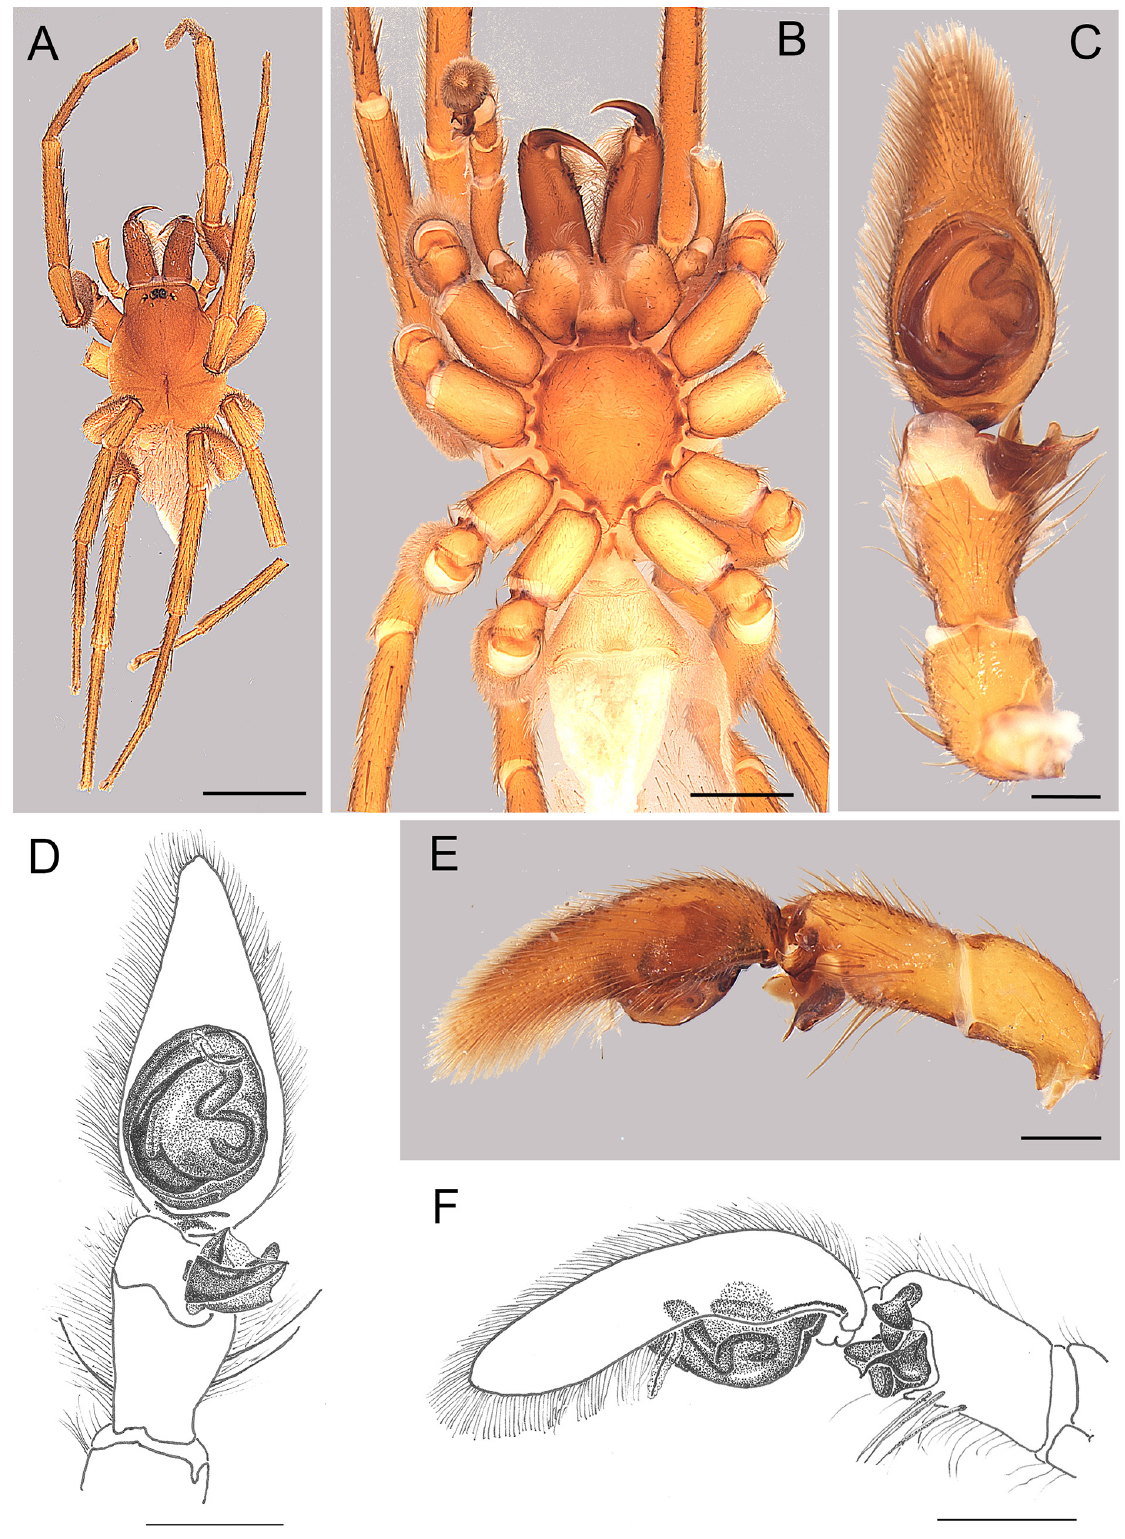
Fig. 36. Andromma velum sp. nov., ♂, holotype (BE_RMCA_ARA.Ara 153251). A . Habitus, dorsal view. B . Same, ventral view. C–D . Left palp, ventral view. E–F . Left palp, retrolateral view. Scale bars: A = 2 mm; B–C = 1 mm; D–F = 0.2